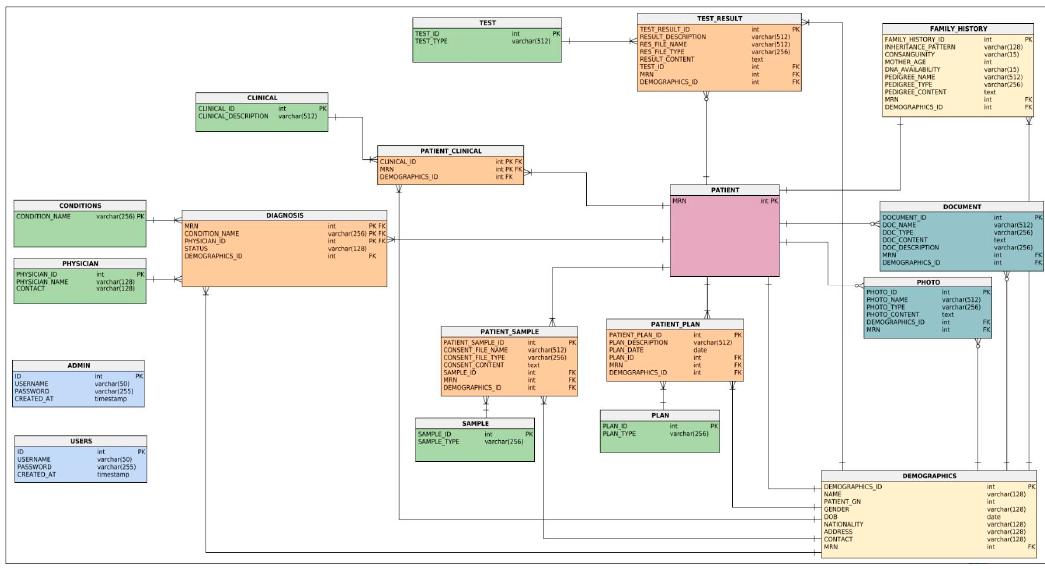
Figure 8. The logical schema.